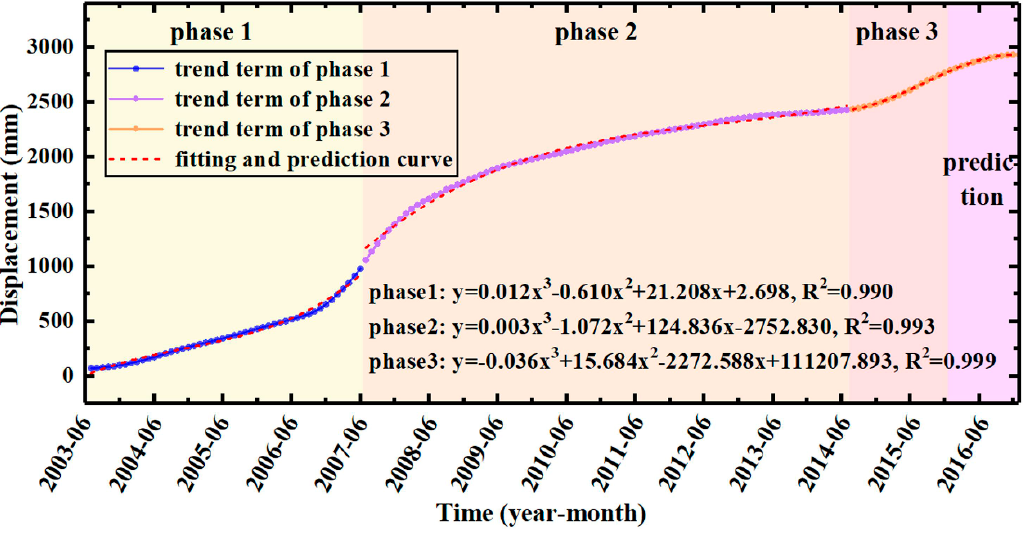
Figure 12. Fitting and prediction curves of the trend term.